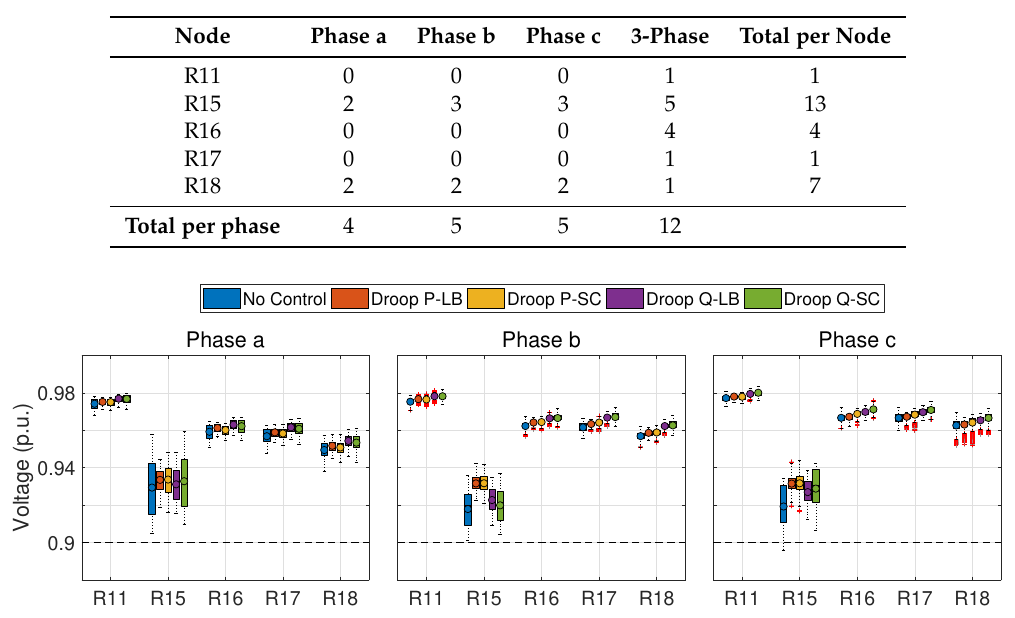
Table 5. Number and phase of EVs connected per node for Scenarios VII, VIII, IX, X, and XI.